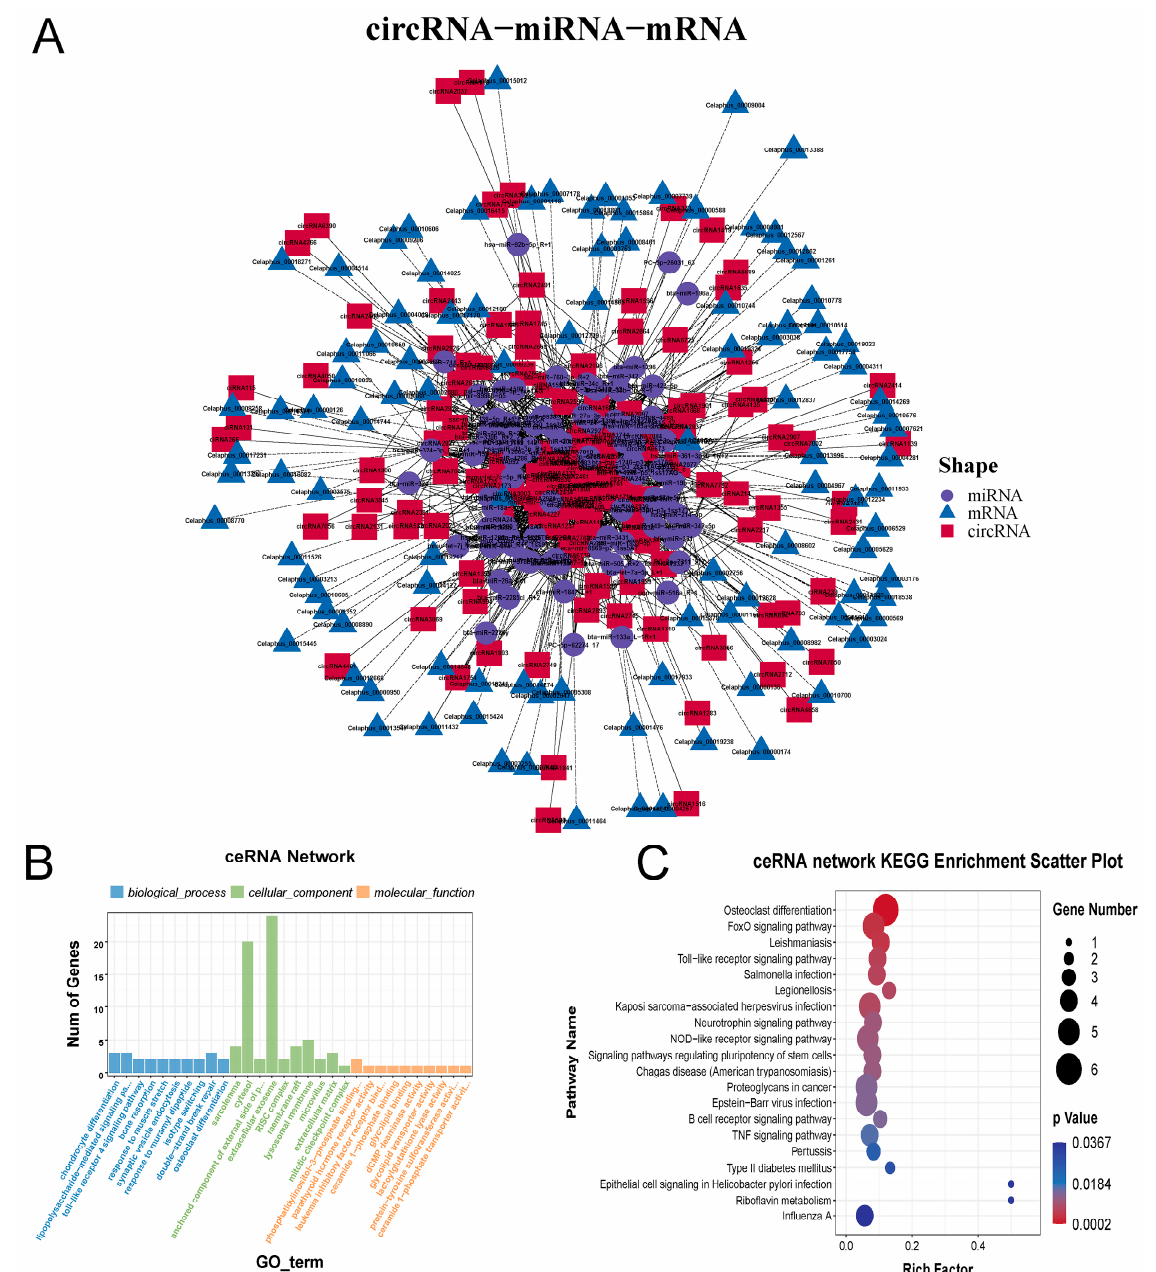
Figure 4. Construction and Analysis of circRNA-miRNA-mRNA ceRNA Network. ( A ) Regulatory networks of circRNA-miRNA-mRNA interactions in mesenchymal and cartilage tissue of antlers. ( B ) The top 10 GO terms of the ceRNA network in biological process, cellular component, and molecular function. ( C ) KEGG analysis of the pathways of the ceRNA network. The figure shows only the top 10 enrichment KEGG pathways.